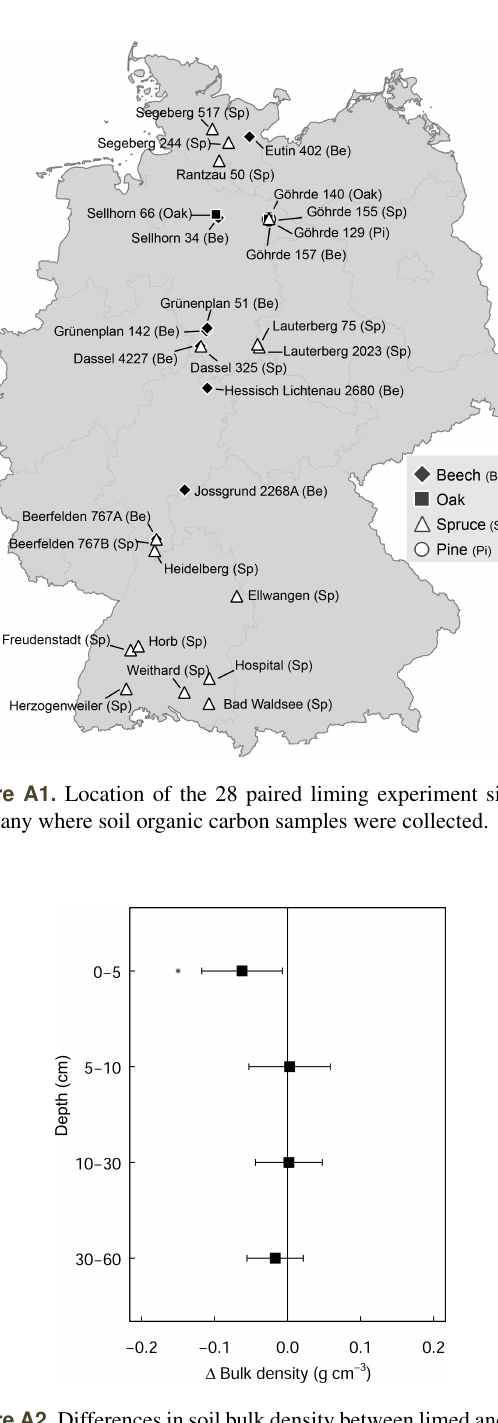
Figure A2. Differences in soil bulk density between limed and con- trol plots. Error bars indicate the 95% confidence intervals based on Student’s T distribution. Statistical significance was tested using LME models for each respective soil depth/layer at P ≤ 0 . 05 (*) and P ≤ 0 . 01 (**).